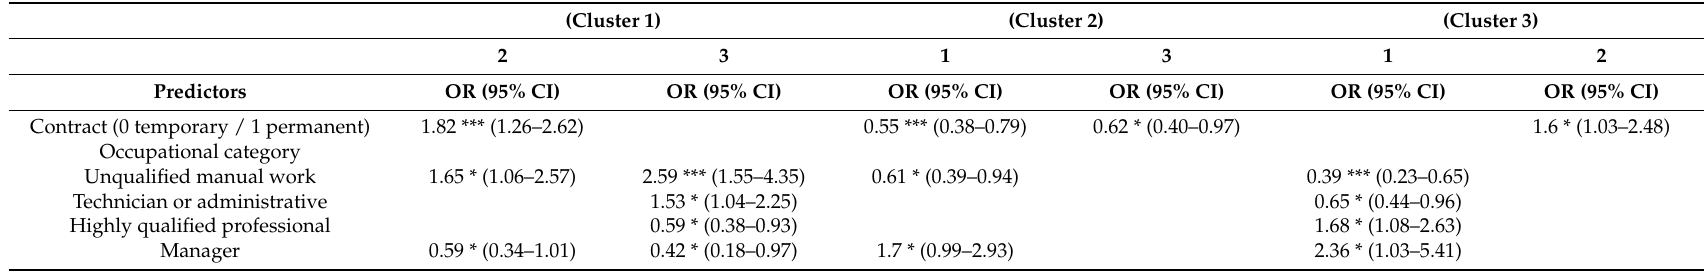
Table 5. Multinomial logistic regression analysis of factors associated with the clusters. Model 3: Hedonic (H) Performance supervisor (PS).